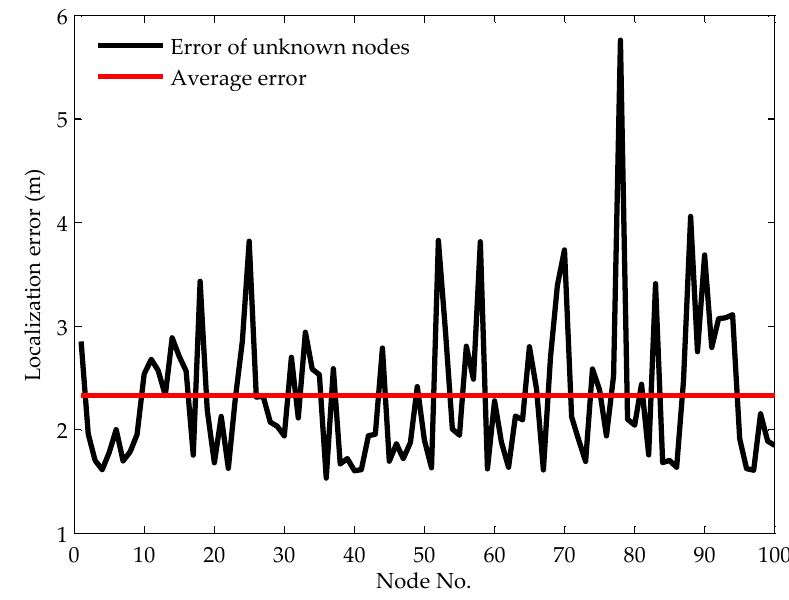
Figure 7. Localization error of each